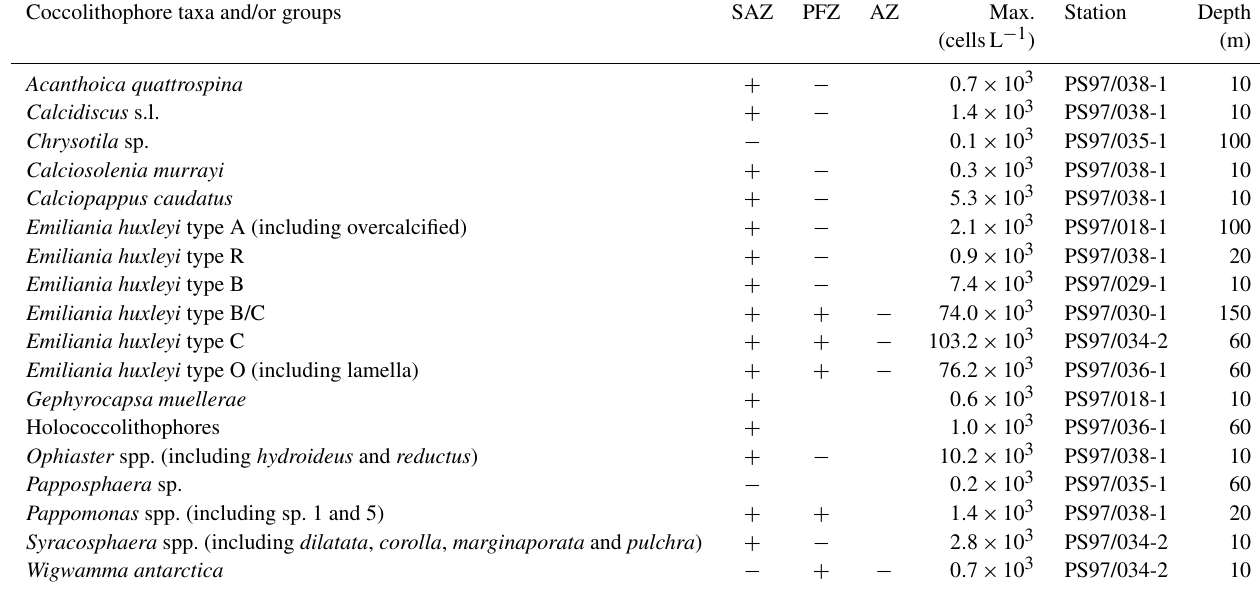
Table 2. Summary of the coccolithophore taxa and groups in the studied plankton samples. The presence of each species in the Subantarctic Zone (SAZ), in the Polar Front Zone (PFZ) or in the Antarctic Zone (AZ) is indicated with “ + ” and with “ − ” if it is occasional. The station and water depth where the maximum number of cells per litre is recorded have also been indicated. Coccolithophore taxa and/or groups SAZ